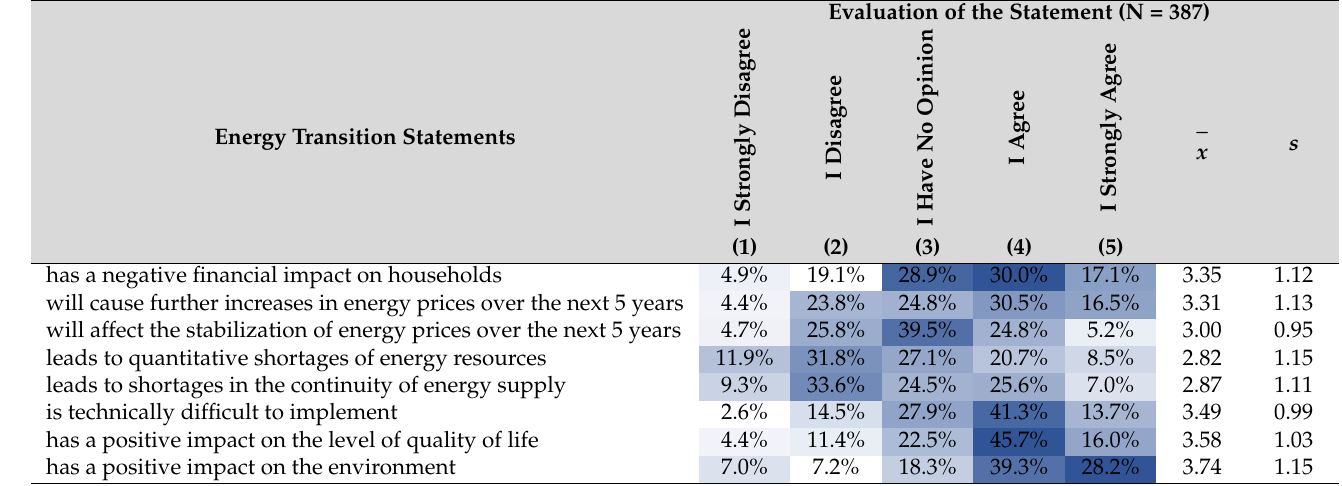
Table 7. The structure of responses regarding the energy transition and the mean score and standard deviation.